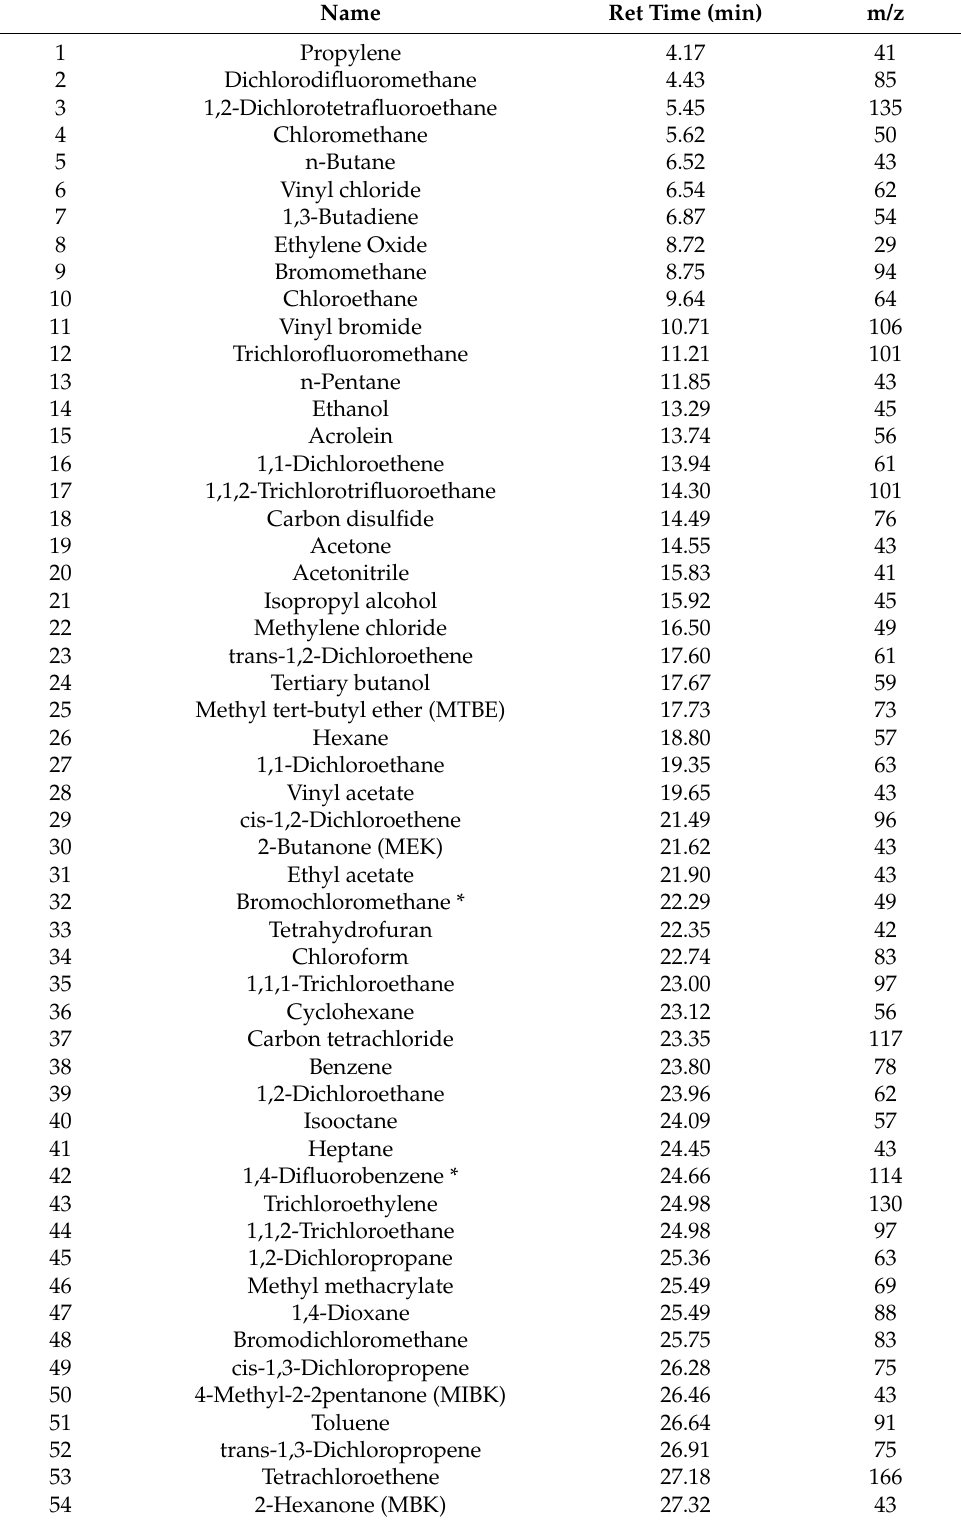
Table 4. Peak names, retention times, and target m/z used for quantitation for TO-15A and EtO method. Compounds marked with * are internal standards or tuning